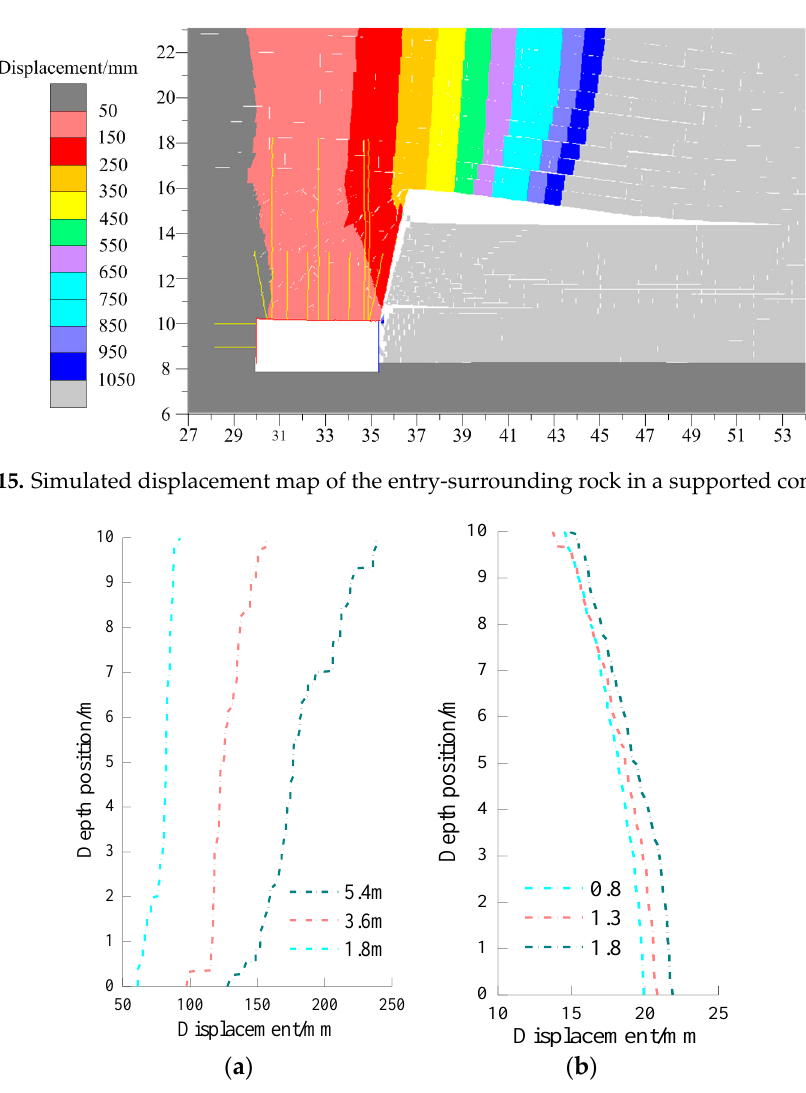
Figure 16. Simulated displacement curves of the surrounding rock in a supported condition: ( a ) Roof; ( b ) rib.